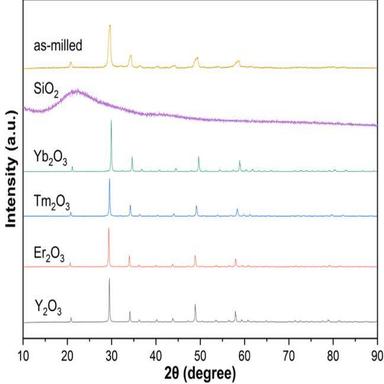
XRD patterns of precursor oxide powders RE2O3 (RE= Y, Er, Tm, Yb) and SiO2.